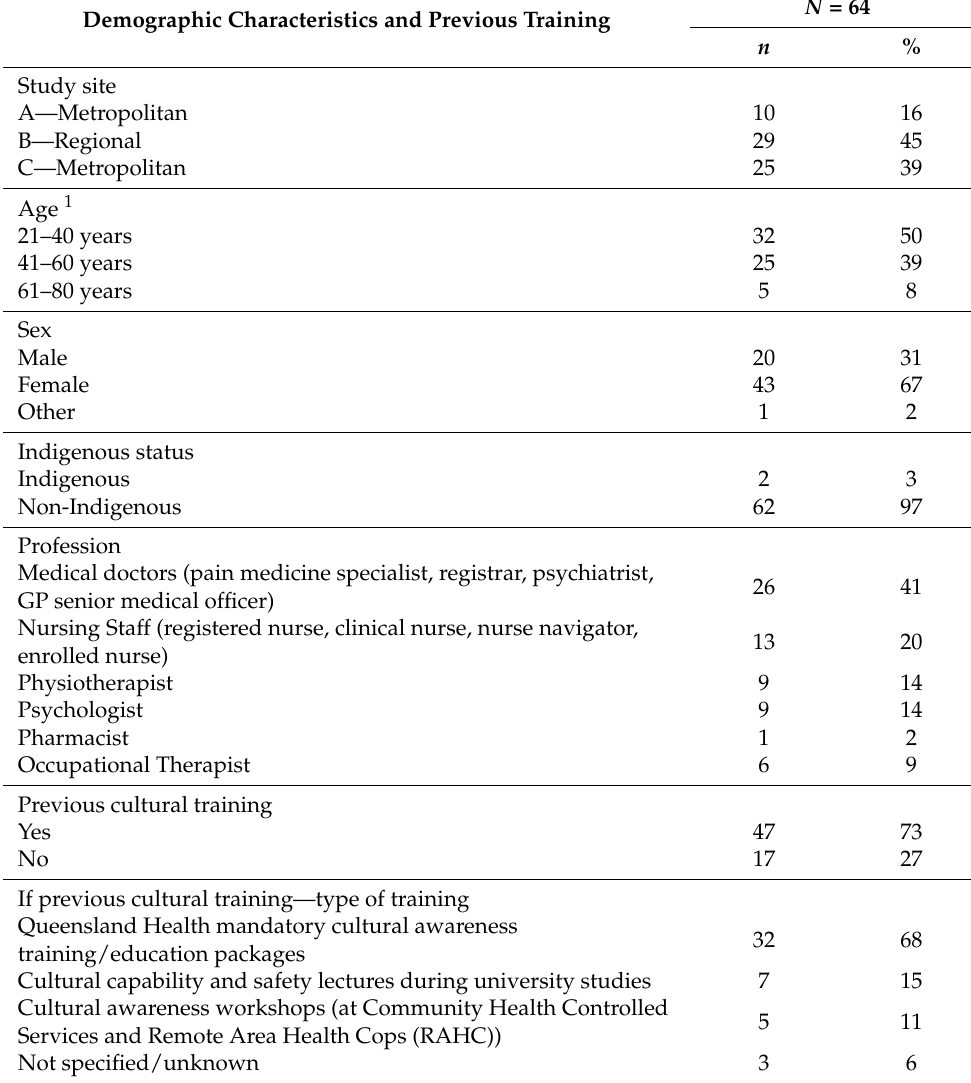
Table 1. Demographic characteristics and previous training information of clinicians who completed the cultural awareness and communication needs survey (CACNS) across the three study sites. Demographic Characteristics and Previous Training